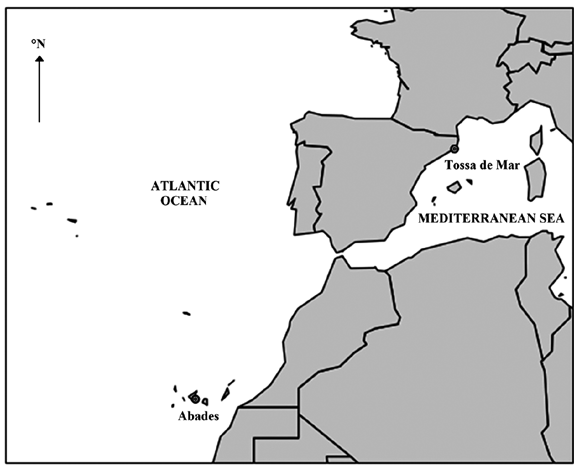
Fig. 1. – Map showing the sampled locations: Abades (Tenerife, Canary Islands) and Tossa de Mar (Costa Brava, northwestern Mediterranean).